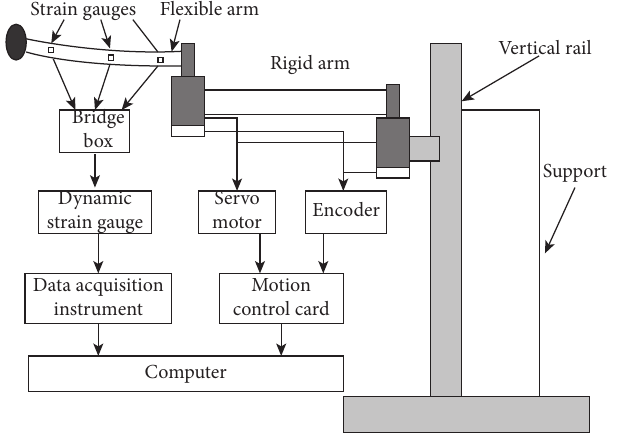
Figure 2: System composition